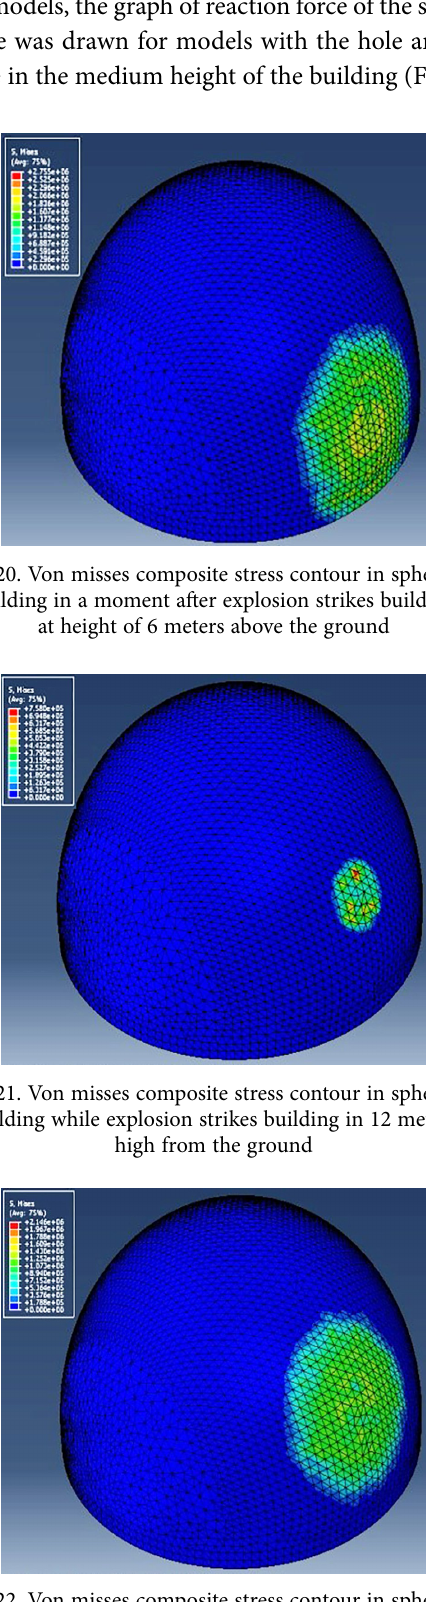
Fig. 22. Von misses composite stress contour in spherical building in a moment after explosion strikes building in 12 meters high from the